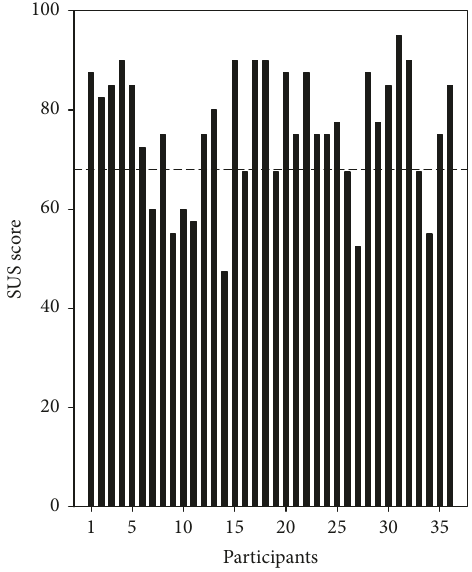
Figure 11: UbiCompass SUS